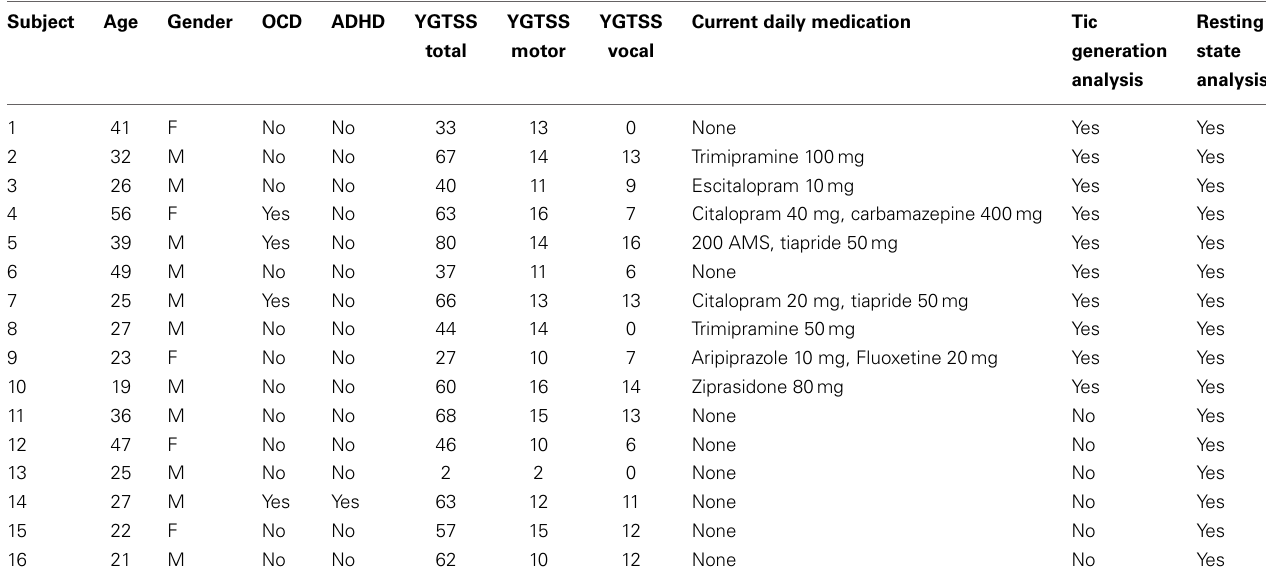
Table 1 | Demographic and clinical data of Tourette patients ( n =